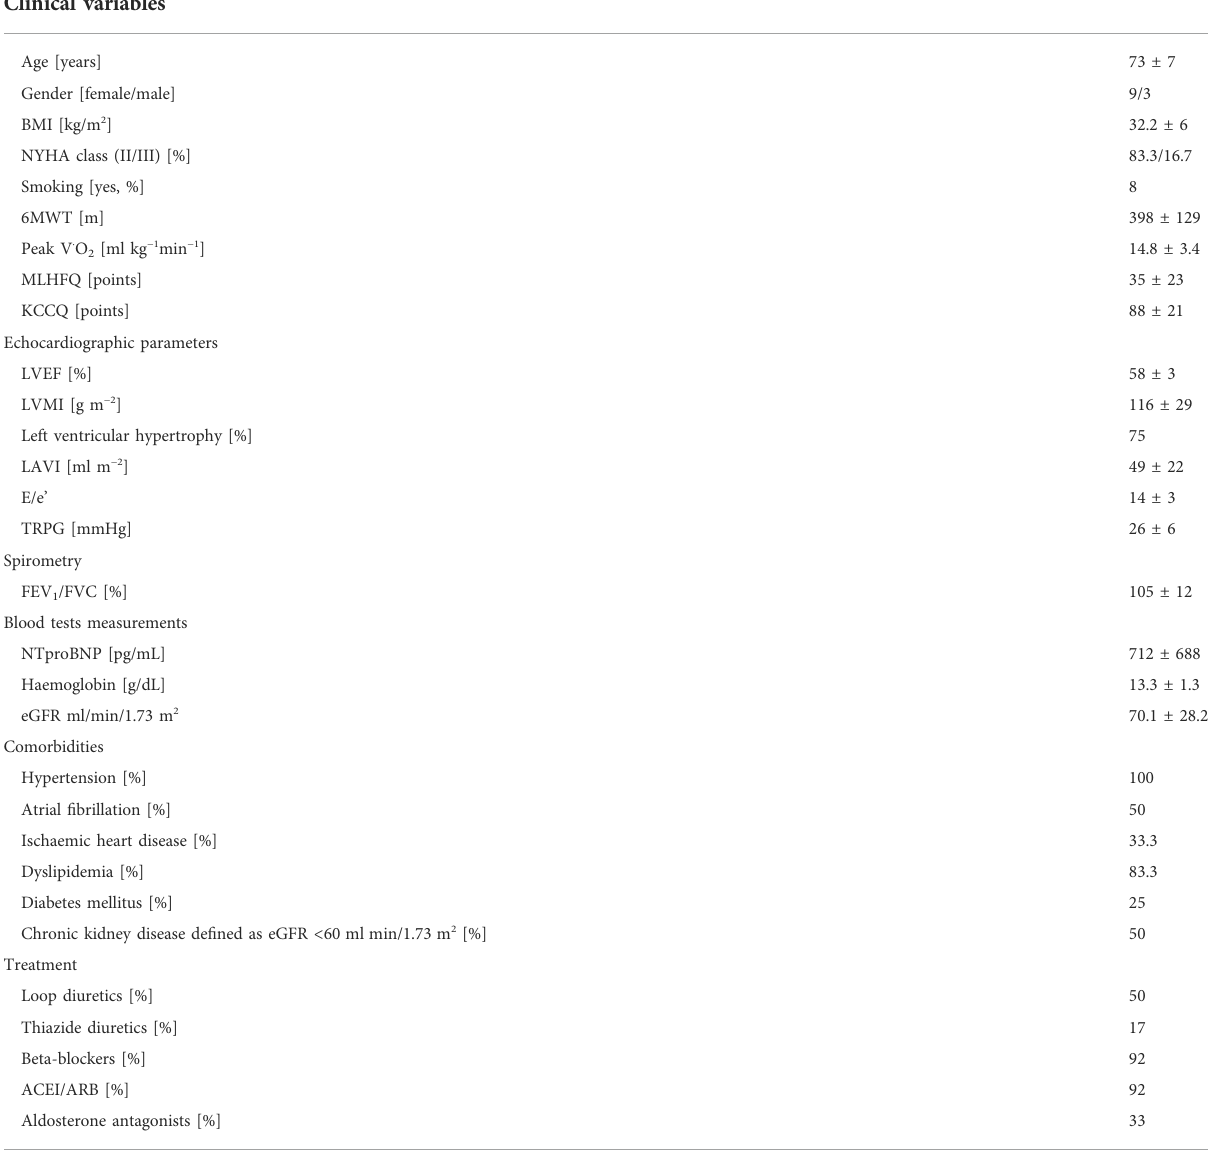
TABLE 1 Clinical characteristics of the study population. Clinical